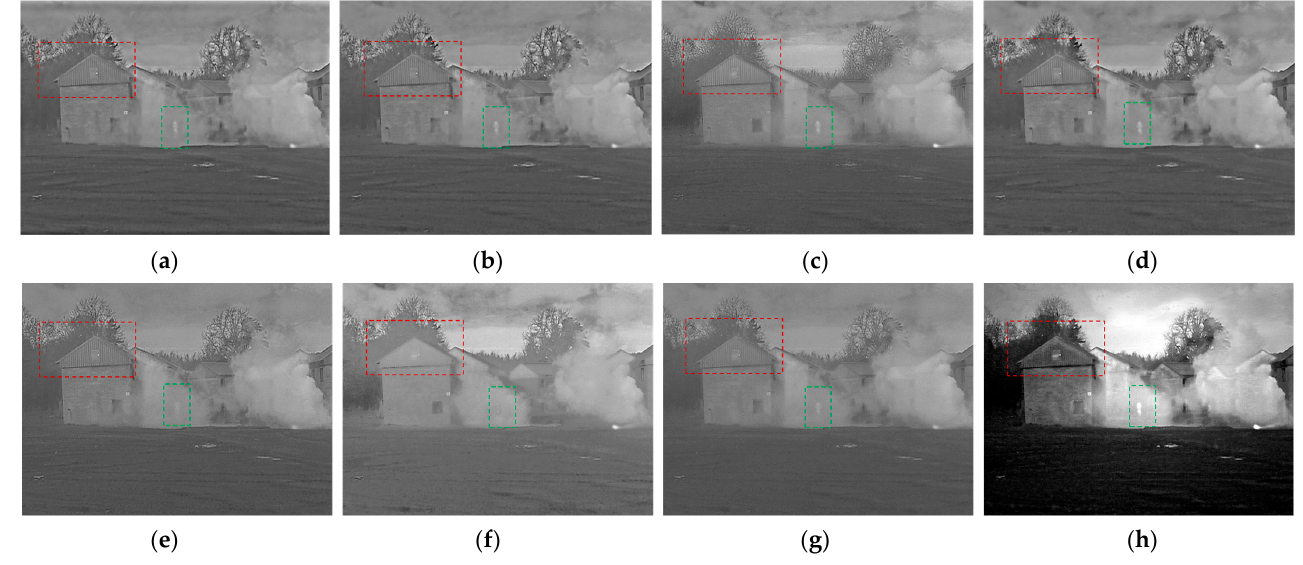
Figure 12. Performance comparison of different fusion methods on the image pair “Octec”. ( a – h ) are the results of CVT, CWT, WLS, LP, ADF, GTF, MSVD and our algorithm, respectively. Finally, the image pair “Road” taken at low illumination is chosen to experiment. In addition, the fusion results based on different algorithms are shown in the Figure 13.